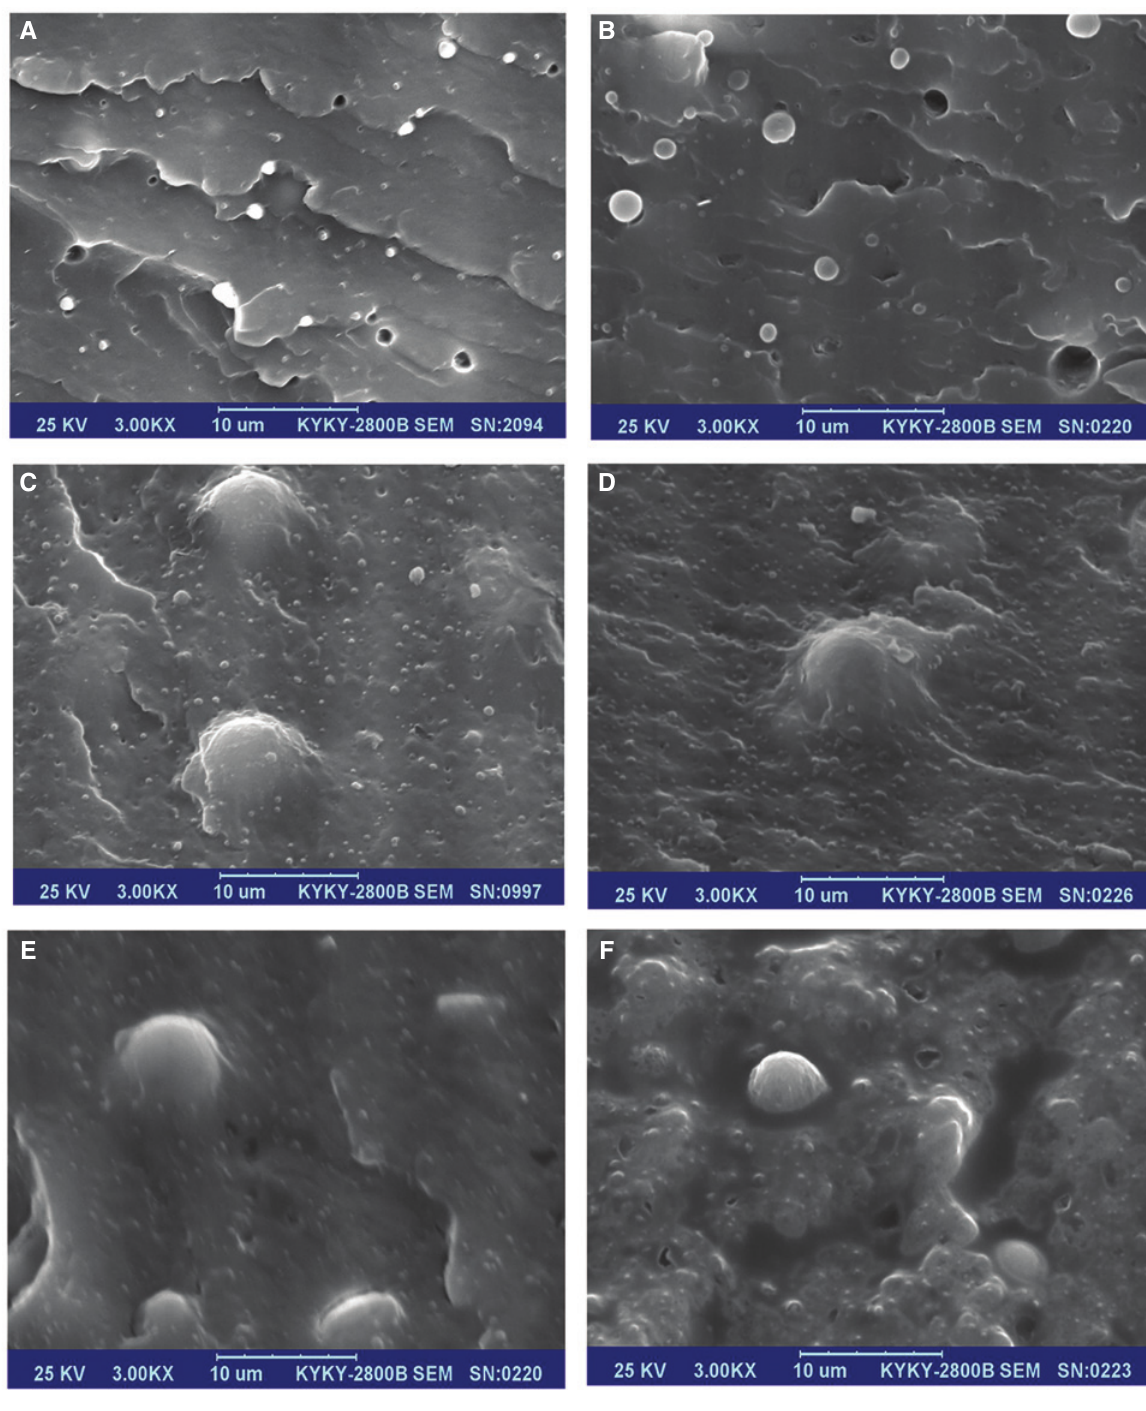
Figure 4 SEM images of LPA6/glass beads/SMA composites. (A) LPA6/glass beads/SMA(100/10/0), (B) LPA6/glass beads/SMA (100/10/2), (C) LPA6/glass beads/SMA (100/10/4), (D) LPA6/glass beads/SMA (100/10/6), (E) LPA6/glass beads/SMA (100/10/8), (F) LPA6/glass beads/SMA